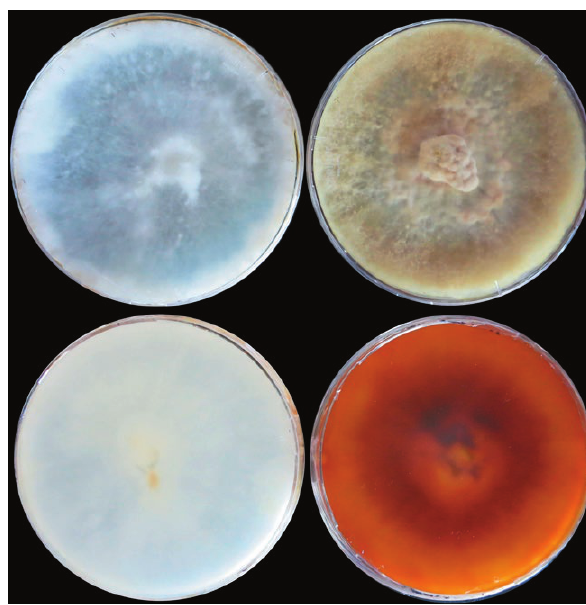
Figure 4. Mycelium cultures of Fomitiporia mediterranea on malt extract agar (ME) after 28 days of incubation. “Type B” (left, sur- face and reverse side) and “Type S” (right, surface and reverse